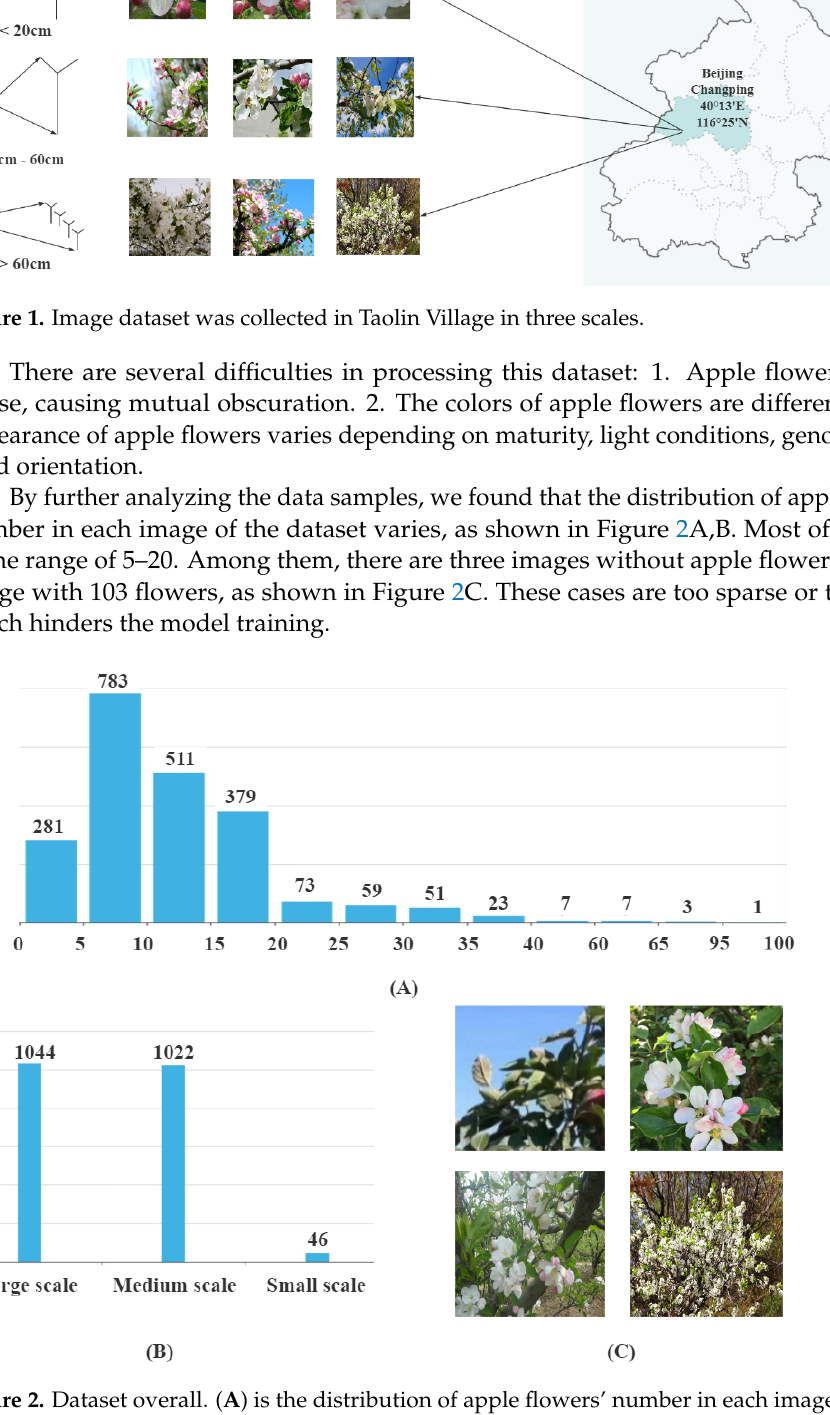
Figure 2. Dataset overall. ( A ) is the distribution of apple flowers’ number in each image; ( B ) is the distribution of different scales of apple flowers in each image; ( C ) shows four samples with different numbers of apple